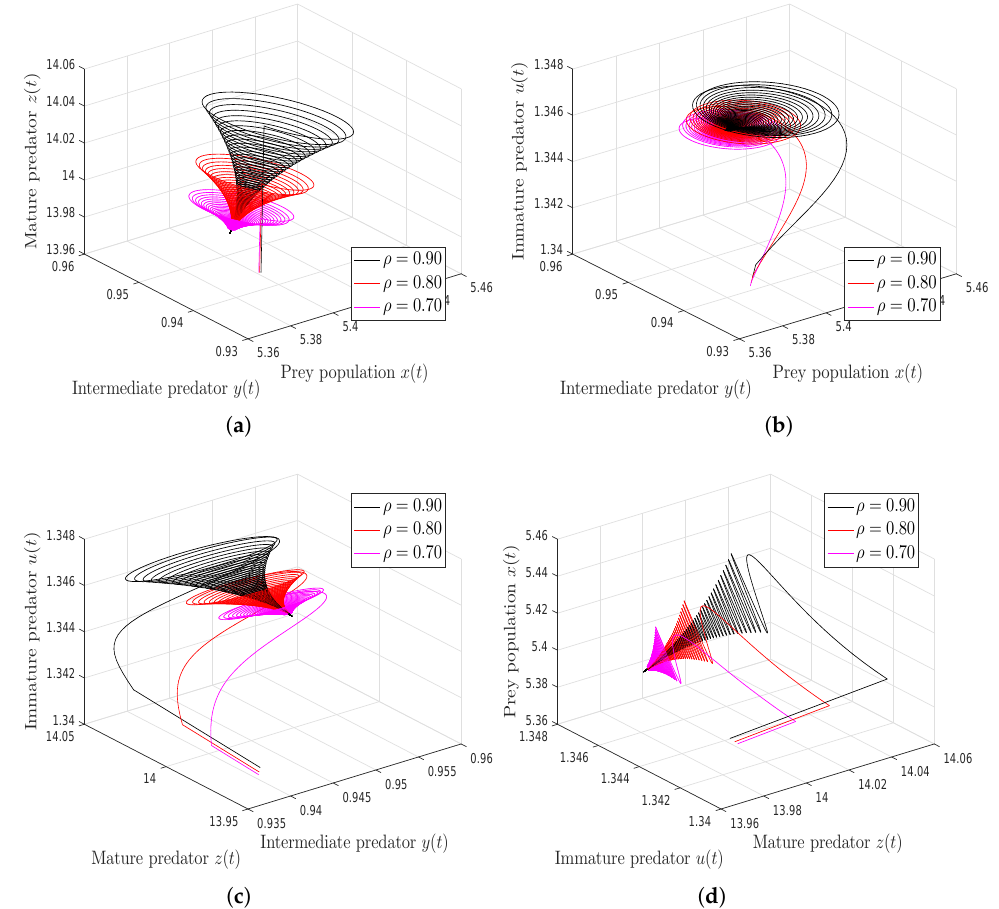
Figure 10. Three-dimensional chaotic phase plot for food web mathematical System (13) with generalized Caputo fractional operator when ϕ =